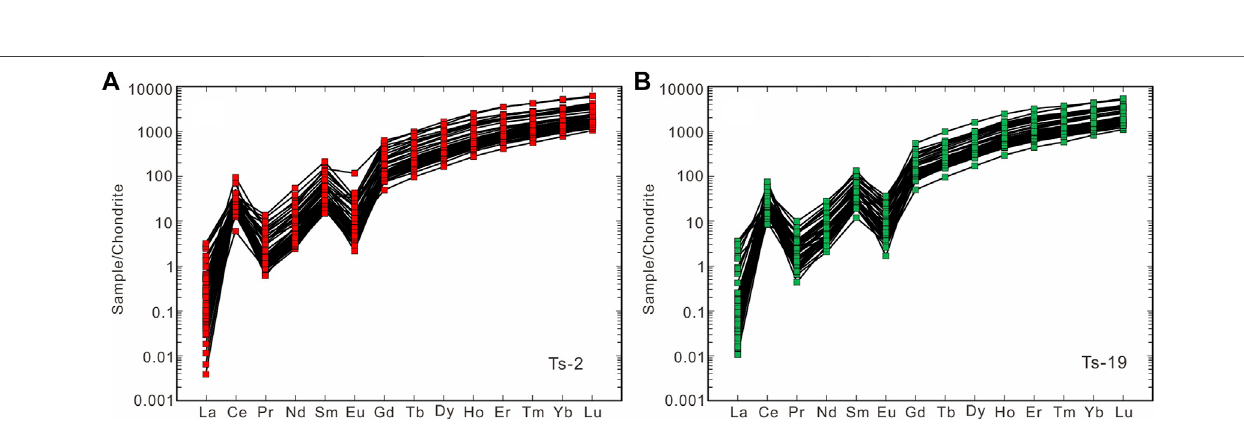
Frontiers in Earth Science |